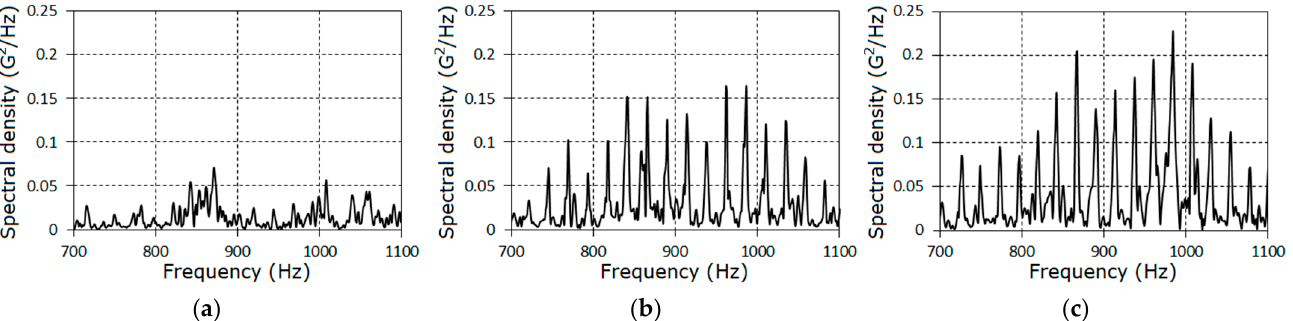
Figure 10. The estimators of the spectral densities of the vibration of stochastic parts in the low-frequency domain for the first ( a ), the second ( b ) and the third ( c ) stages.